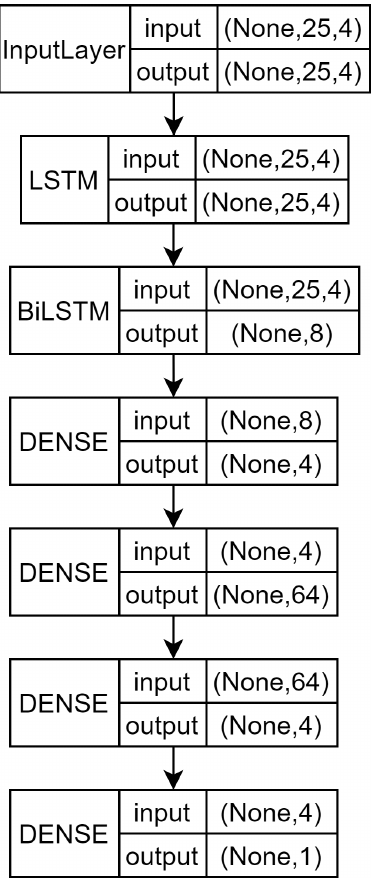
Figure A5. Sun’s Bi-LSTM NN architecture block